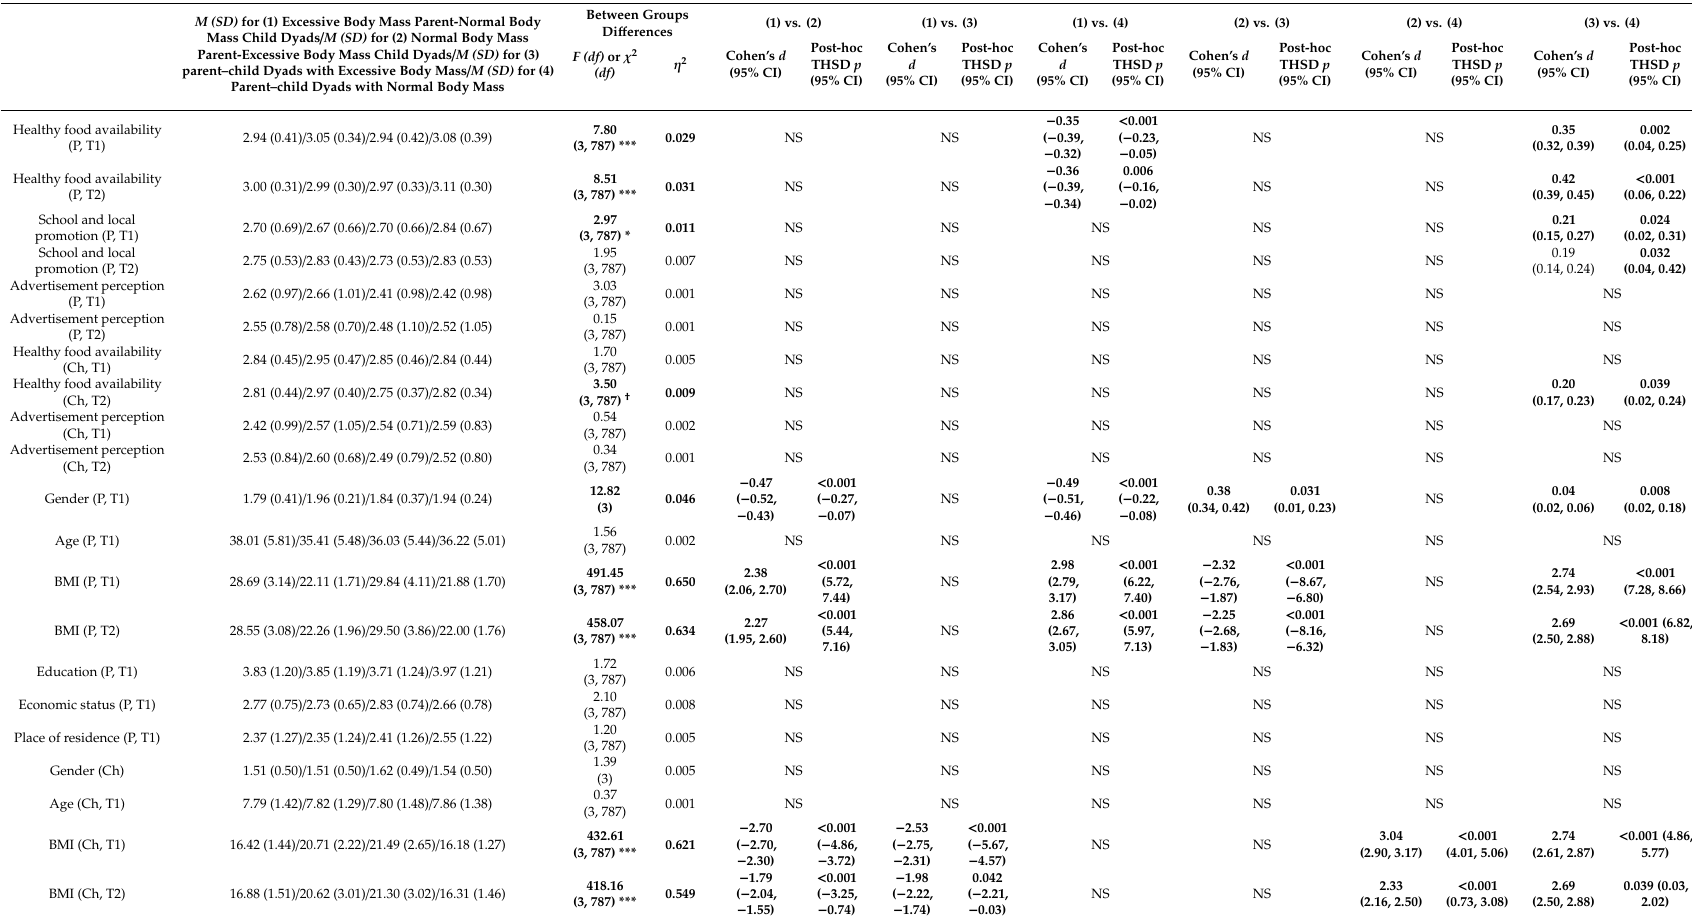
Table A4. Di ff erences in the study variables and demographic variables between excessive body mass parent-normal body mass child dyads ( n = 193), normal body mass parent-excessive body mass child dyads ( n = 88), parent–child dyads with excessive body mass ( n = 129), and parent–child dyads with normal body mass ( n =